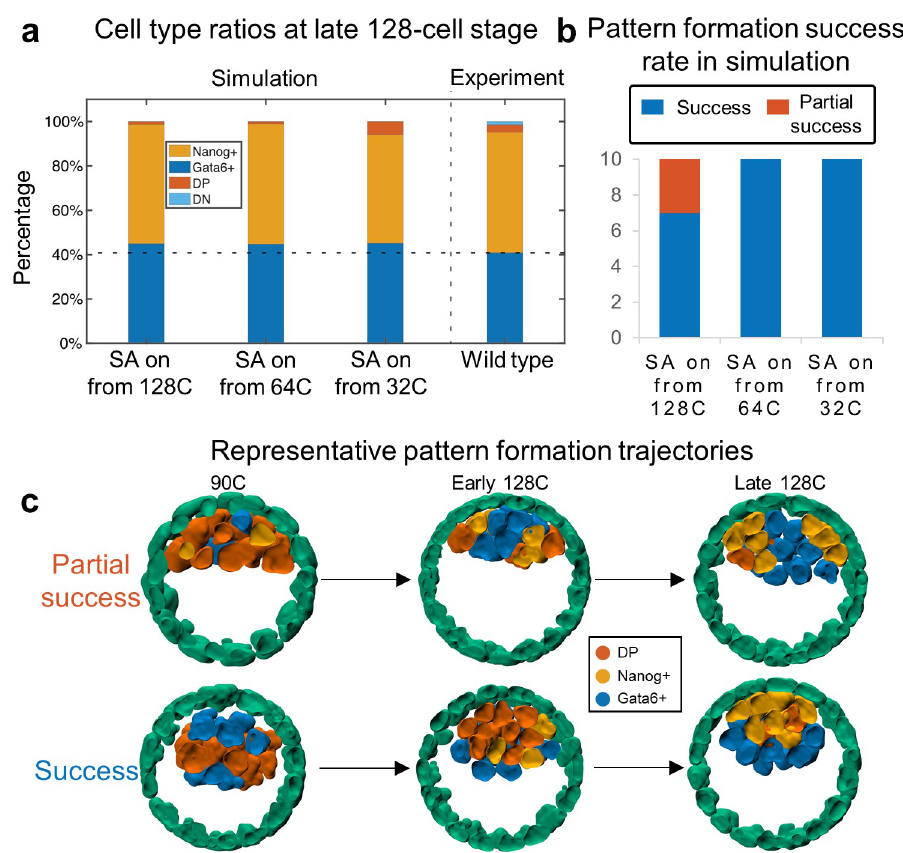
Fig 3. Sensitivity of selective adhesion starting time. (a) Ratio of Nanog+/Gata6+/DP/DN at 128-cell stage for different selective adhesion (SA) starting time; (b) Success rate for embryo development at 128-cell stage for different SA starting time. (c) Spatial pattern of simulation where selective adhesion starts from 128-cell stage (a partially successful case) and simulation where selective adhesion starts from 64-cell stage (a successful